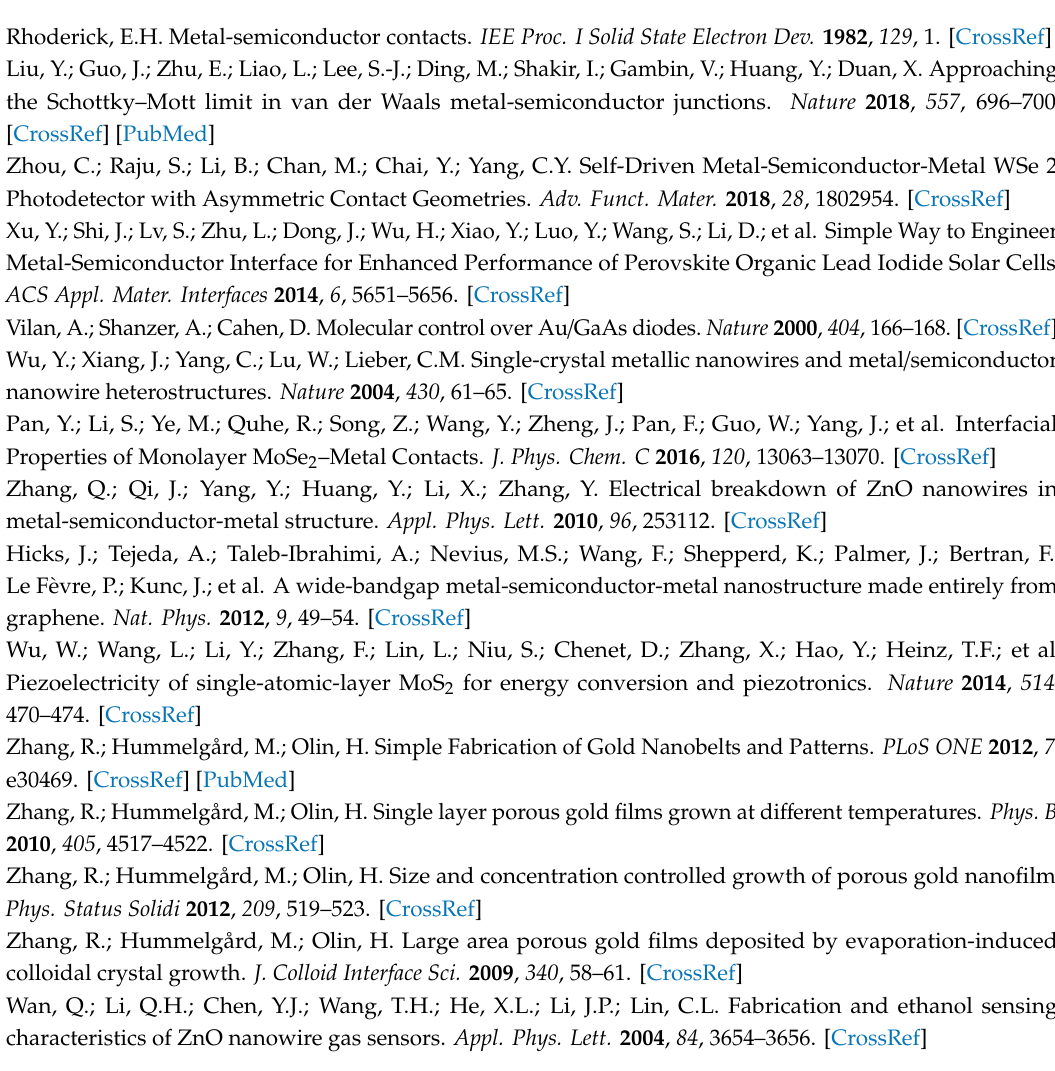
Figure S1: Photograph of gold nanobelt on silica wafer, silver electrodes deposited on (M-S) n film, and the mounted sensor in a